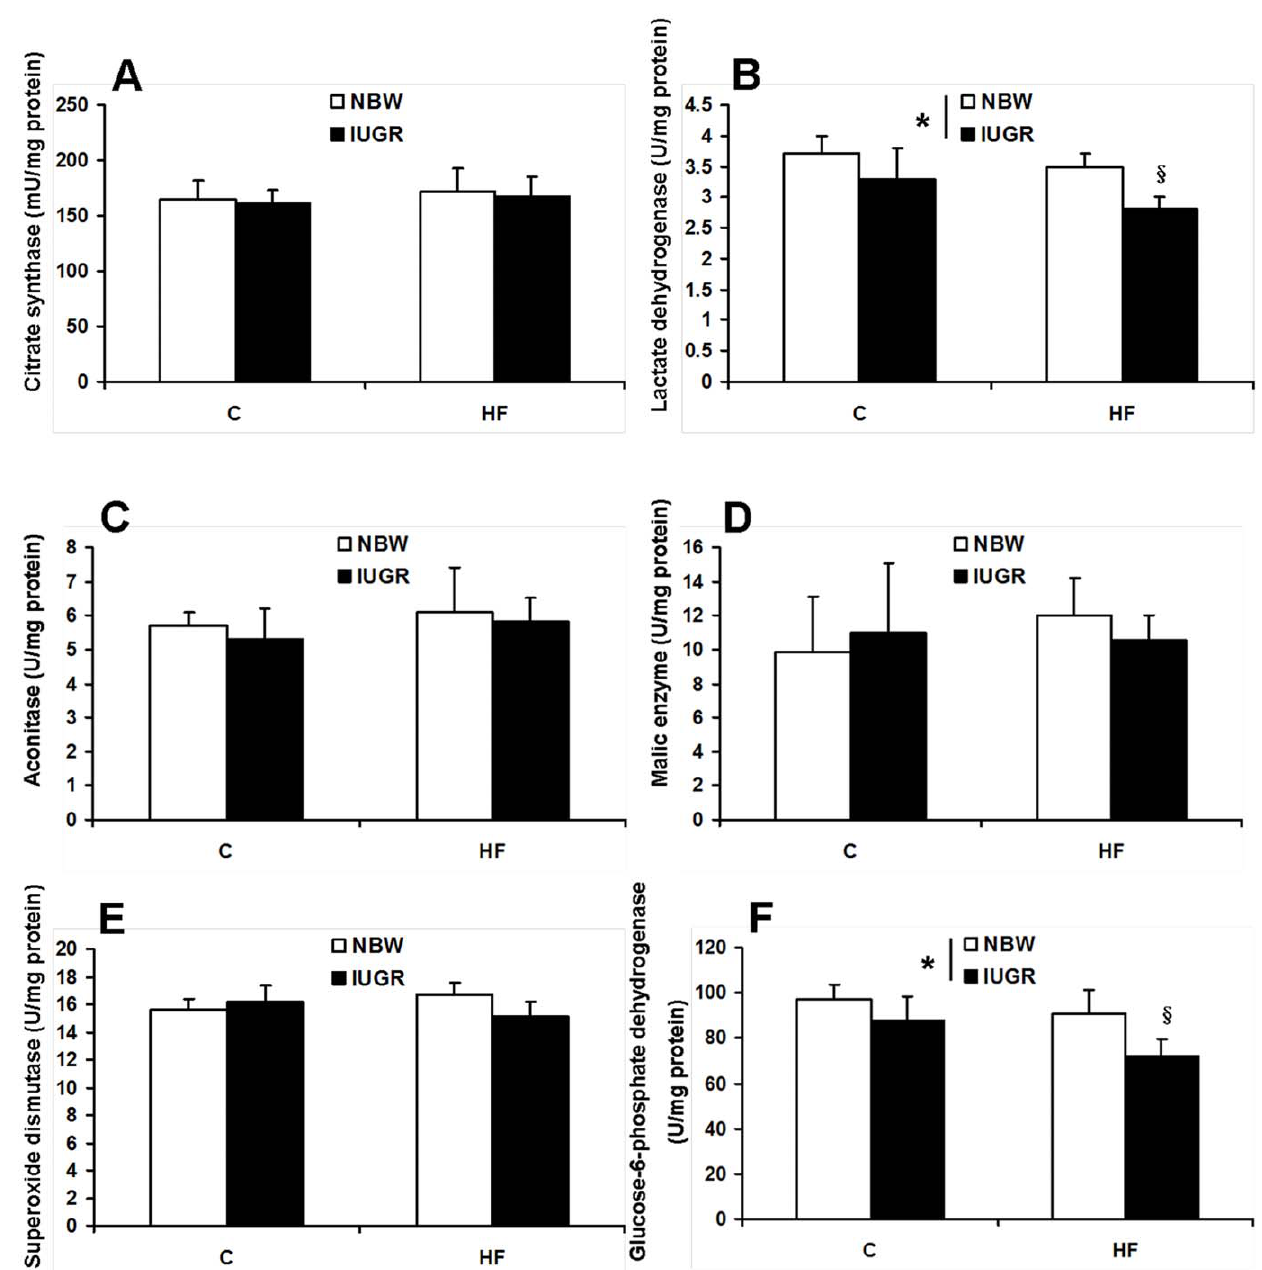
Figure 4. Influence of IUGR and diet on activities of CS (A), LDH (B), aconitase (C), ME (D), SOD (E) and G6PD (F) in skeletal muscle of pigs. C: Control diet; HF: High-fat diet; NBW: Normal birth weight; IUGR: Intrauterine growth retardation. Data are expressed as group means 6 SEM. * P values next to each label represent the significance in the effect for each source of variation (IUGR or diet) as calculated by ANOVA. 1 P , 0.05 in post hoc test comparing IUGR and NBW offspring receiving the same diet (n=8 by group).